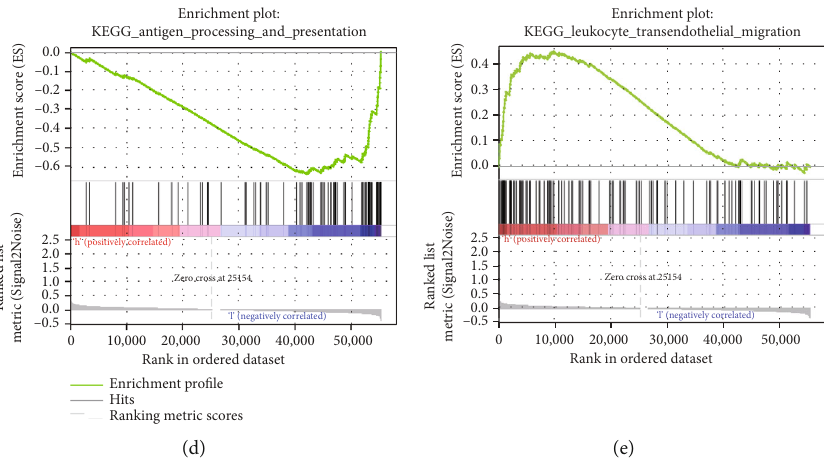
Figure 5: Functional analyses of the m6A-associated lncRNA signature. (a) Heatmap of pathways. (b) Negatively enriched pathways. (c) Positively enriched pathways. (d) Antigen processing and presentation pathway. (e) Leukocyte transendothelial